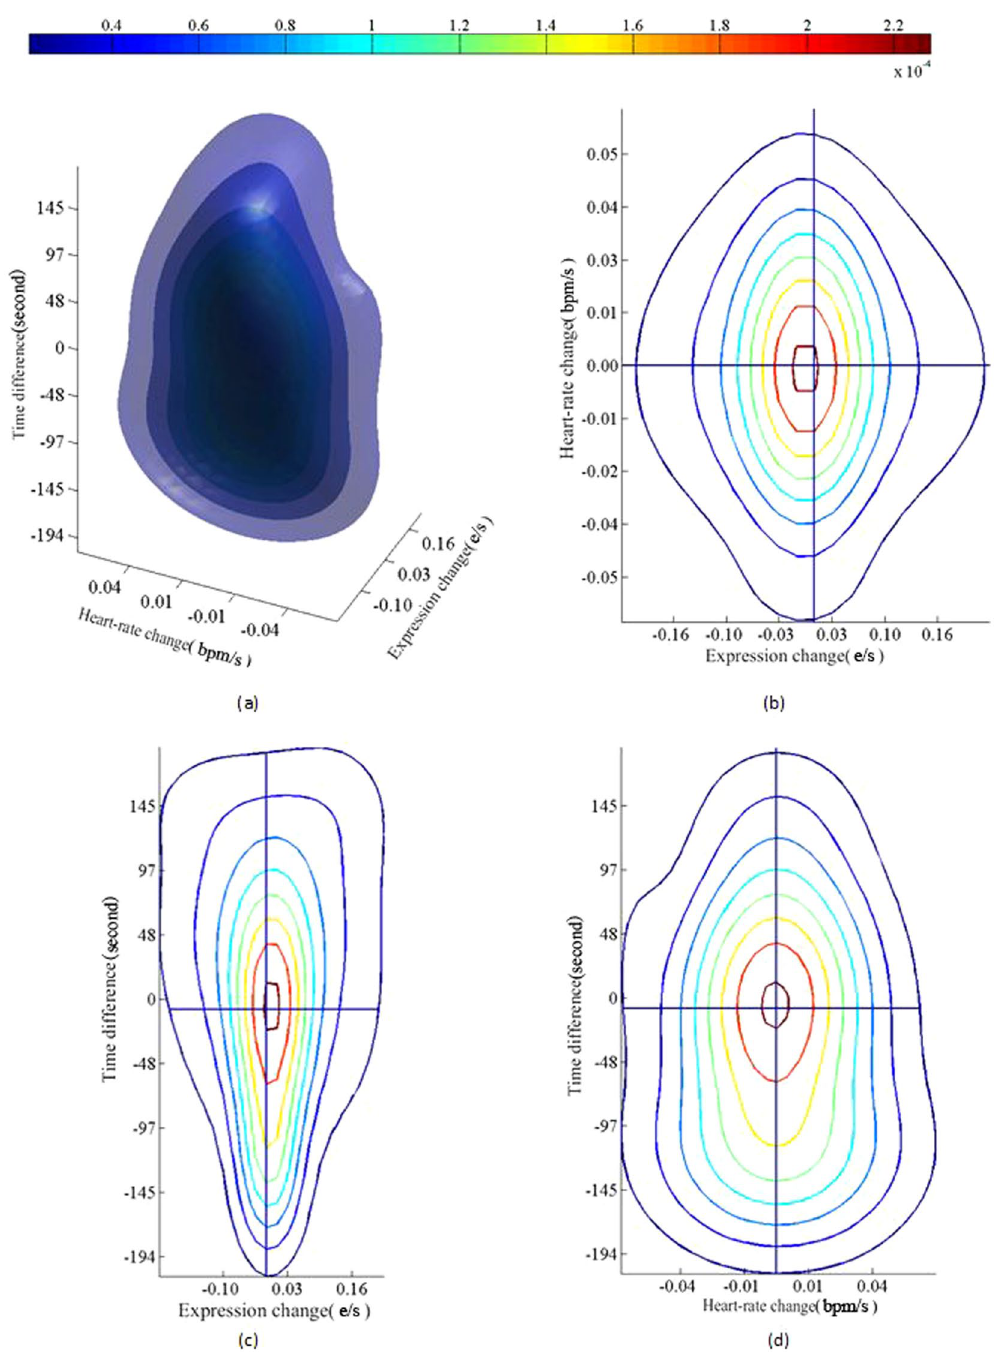
Figure 4. Density map of 3D SAS and its sectional views. Different colors denote different isosurfaces (i.e. the same density value). The three dimensions of SAS are measured respectively per second, the unit “bpm/s” and the unit “E/s”, wherein the character “ E ” is the shortened form of EE defined in Equation